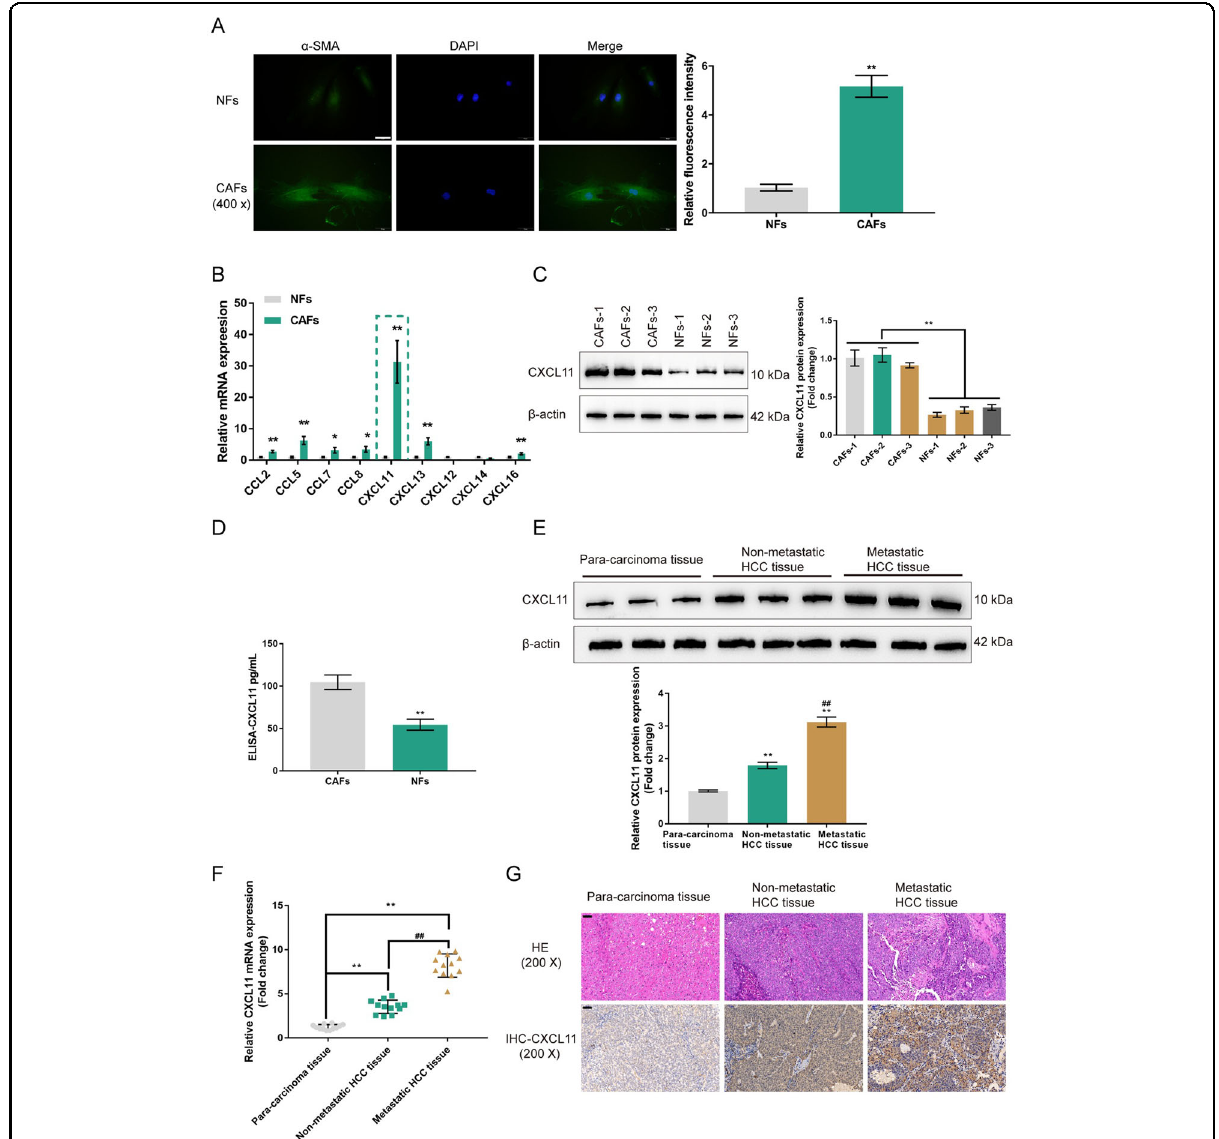
Fig. 1 Expression of CXCL11 in tissue samples and cancer-associated fi broblasts (CAFs). A CAFs and normal fi broblasts were isolated from cancer tissues and noncancerous normal tissues, respectively, and identi fi ed for α -SMA protein content and distribution by Immuno fl uorescent (IF) staining. The relative fl uorescence intensity was shown in the right panel. N = 5. B The mRNA expression of CXCL13, CXCL12, CCL2, CXCL11, CXCL16, CCL8, CXCL26, CXCL5, CXCL14, CCL5, and CCL7 was examined in CAFs and NFs using real-time PCR. C The protein levels of CXCL11 were examined in CAFs and NFs using Immunoblotting. D The contents of CXCL11 in the culture medium were determined by ELISA. E The protein levels of CXCL11 were examined in 12 cases of para-carcinoma tissues, 12 cases of nonmetastatic HCC tissues, and 12 cases of metastatic HCC tissues using Immunoblotting. F The mRNA expression of CXCL11 was examined in 12 cases of para-carcinoma tissues, 12 cases of nonmetastatic HCC tissues, and 12 cases of metastatic HCC tissues using real-time PCR. G The histopathological features of para-carcinoma tissues, nonmetastatic HCC tissues, and metastatic HCC tissues were examined by H&E staining. The protein contents of CXCL11 in para-carcinoma tissues, nonmetastatic HCC tissues, and metastatic HCC tissues were examined by Immunohistochemical (IHC) staining. * P < 0.05, ** P < 0.01, compared with NFs group or para-carcinoma tissue group; ## P < 0.01, compared with the nonmetastatic HCC tissue